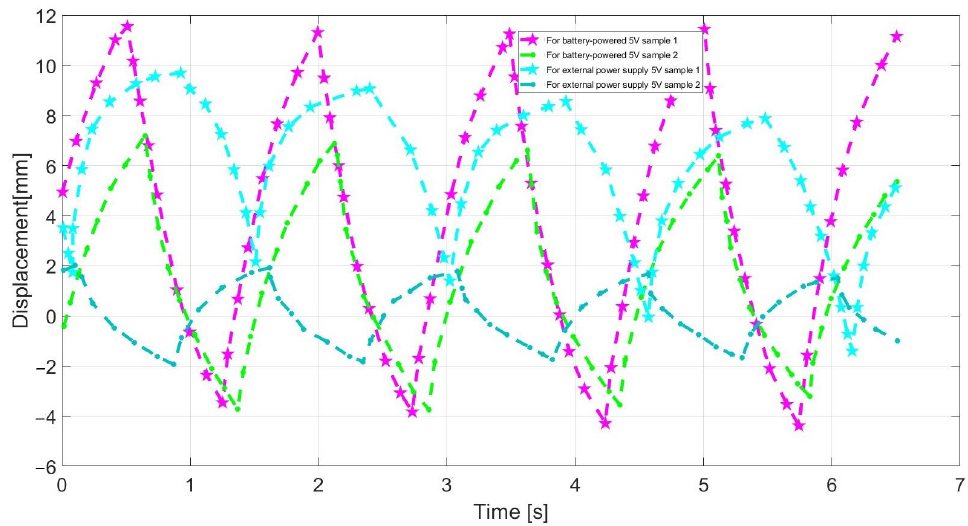
Figure 4. The displacement values for strip samples that had produced good results when powered by an external source and by a